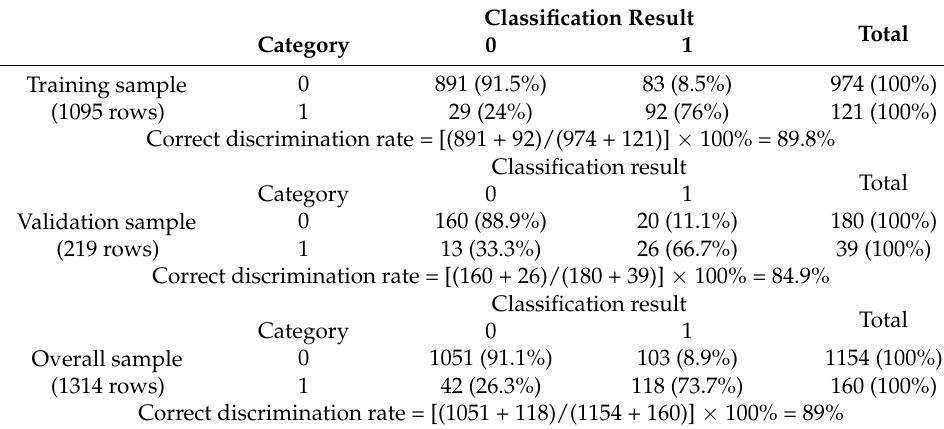
Table 13. Discriminant-analysis